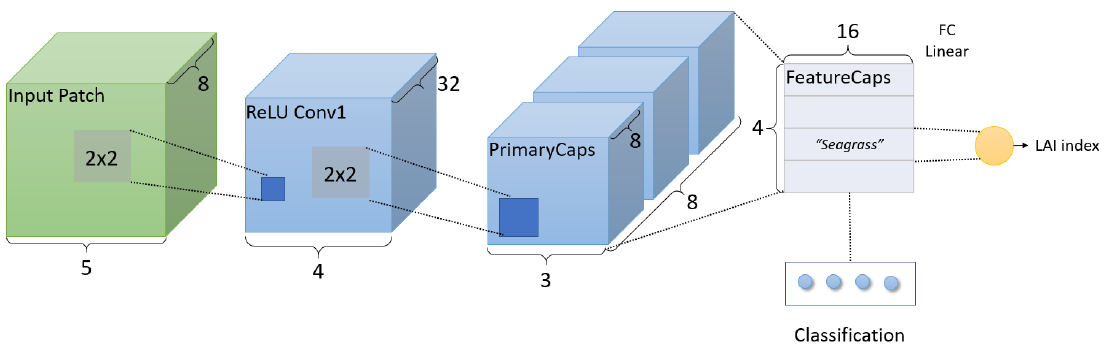
Figure 3. Diagram of the proposed deep capsule network for end-to-end seagrass identification and LAI